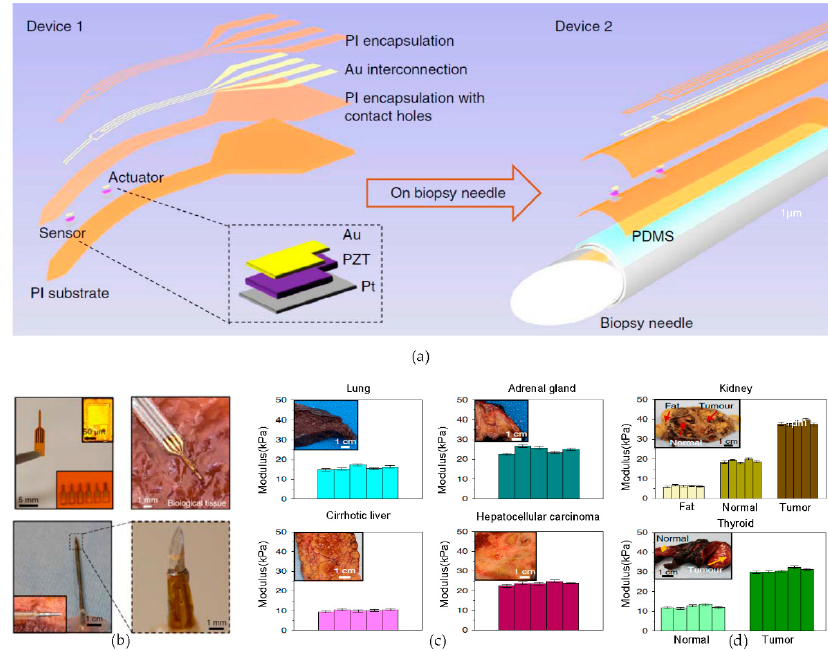
Figure 2. Flexible, piezoelectric tissue modulus recording probes: ( a ) Illustrations of two main piezoelectric material lead zirconate titanate (PZT)-based modulus probes, the free-standing device (left) and the conformally attached device on a biopsy needle (right); ( b ) pictures of self-standing devices (top) and the device on a biopsy needle (bottom), an inset picture (top, upper-right) designates a sensor/actuator pair, and the other inset picture (top, down-right) shows a row of completed designs. The magnified picture (bottom) shows specific actuator/sensor sites; ( c , d ) the measured modulus results for human tissues in a variety of organs using the PZT-based probe, the inset pictures of the upper-left side of the respective graphs show the optical images of organs in which modulus sensing is conducted. Reproduced with permission from 2018 Nature [50].